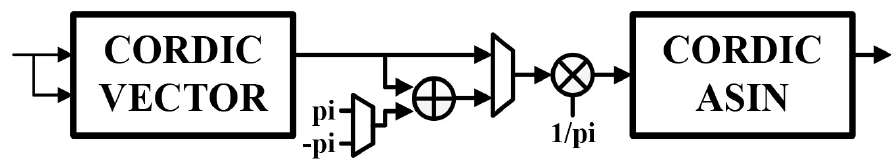
Figure 10. Hardware architecture of angle estimation module